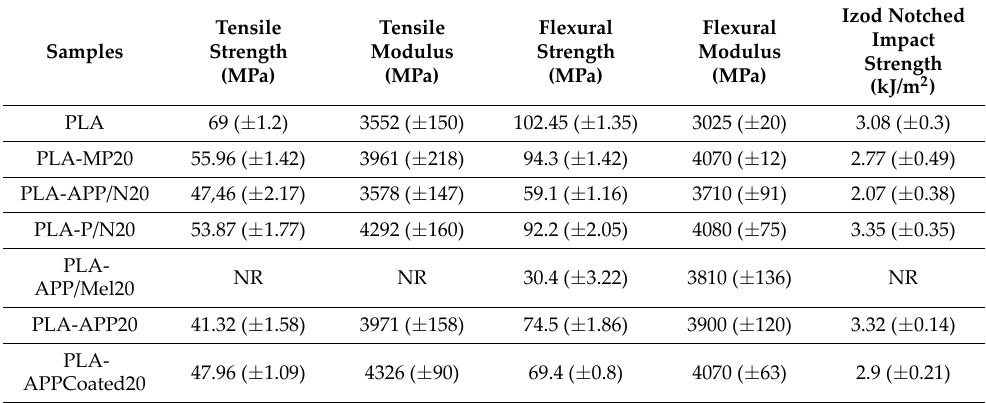
Table 4. Mechanical test results of PLA with different FR